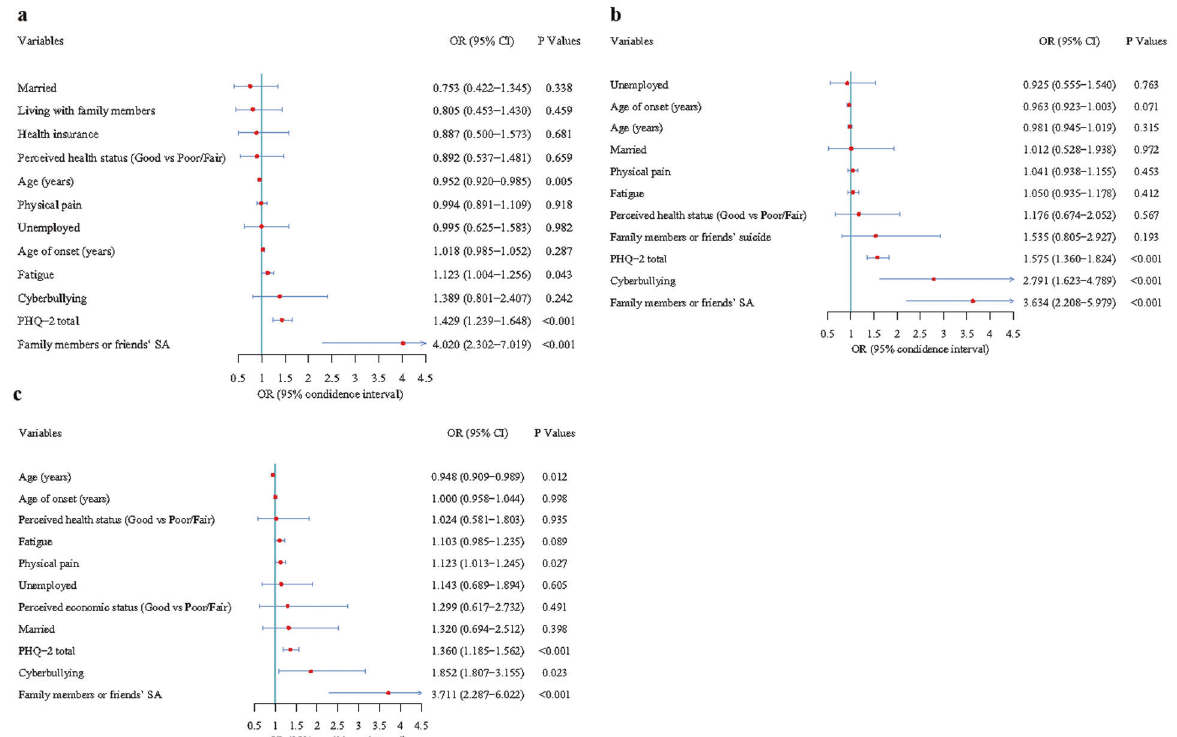
Fig. 2 Independent correlates of suicidal ideation, suicide plan and suicide attempt in patients with bipolar disorder by multiple logistic regression analyses. Note: a , suicidal ideation; b , suicide plan; c , suicide